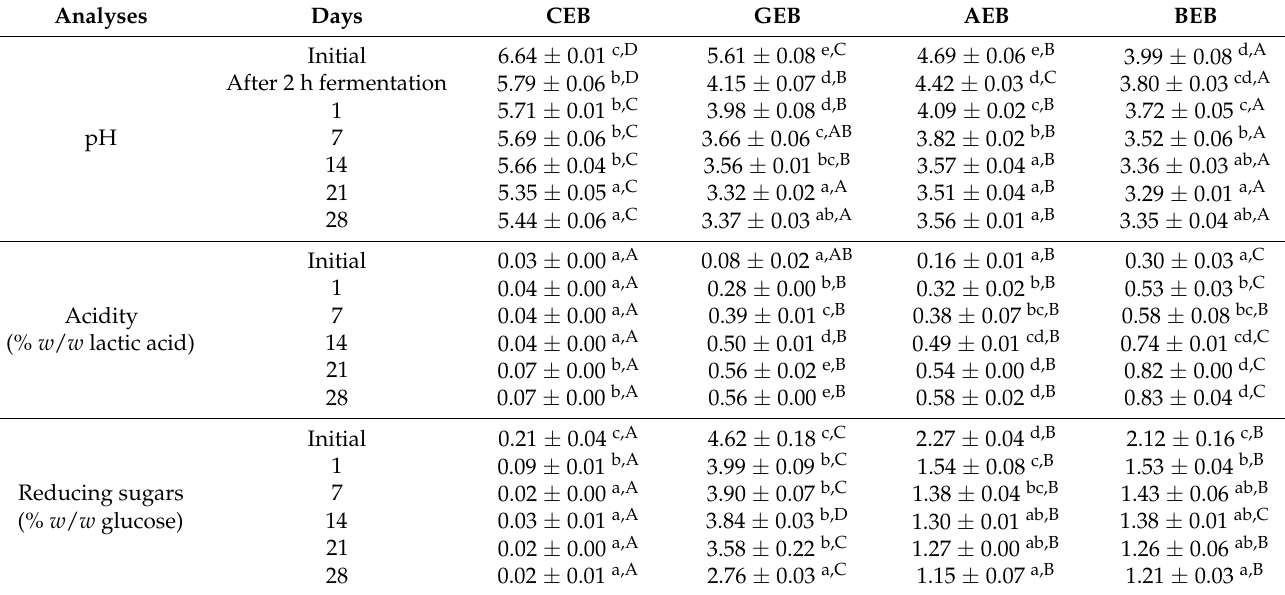
Table 1. Effect of storage on pH values, acidity and reducing sugars of the beverages. Analyses Days CEB GEB AEB